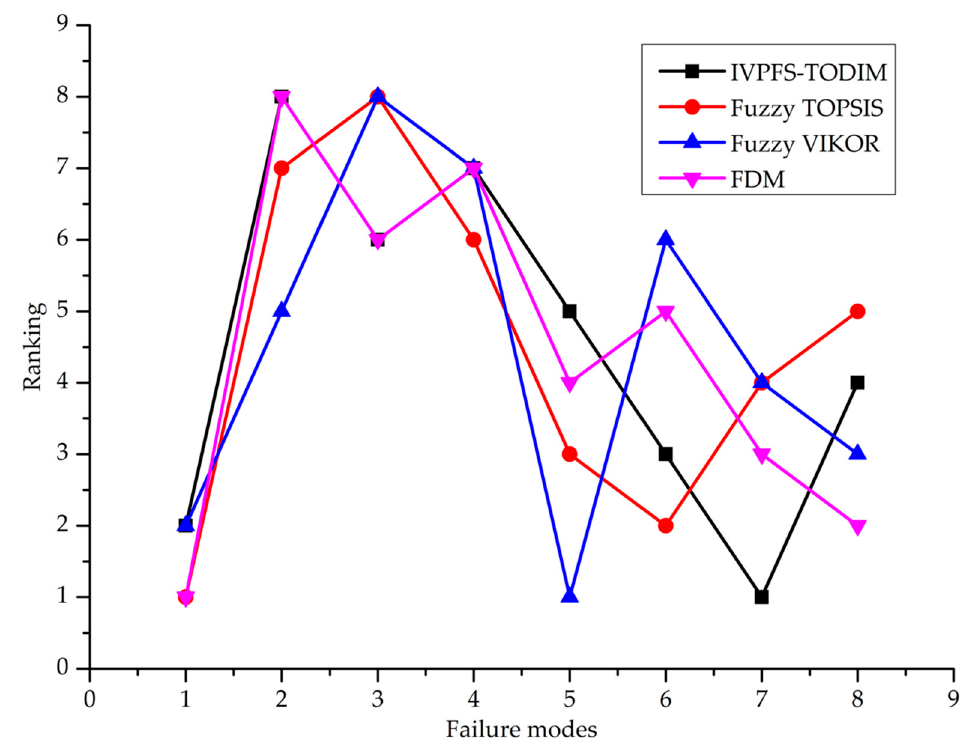
Figure 3. Comparative rankings of failure modes.